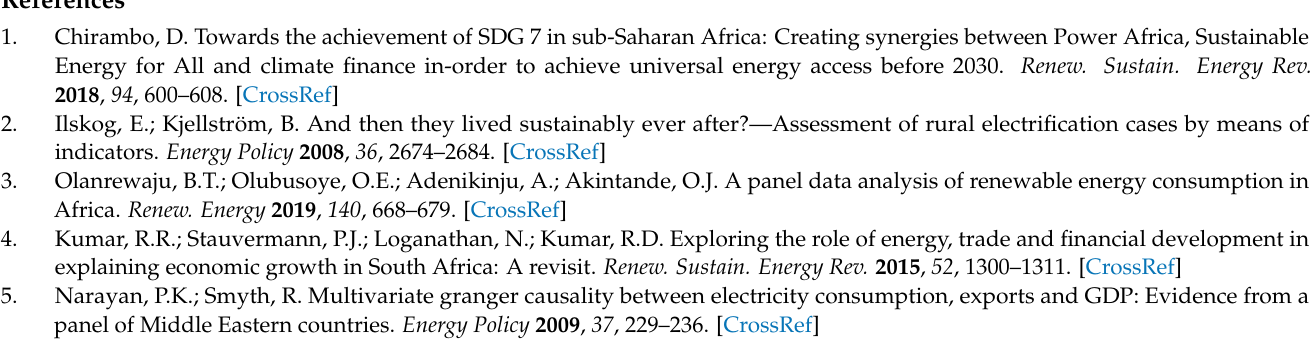
Figure A2. A model of the learning process using the decision tree method to classify changes in the size of the variables under study. Source: own study